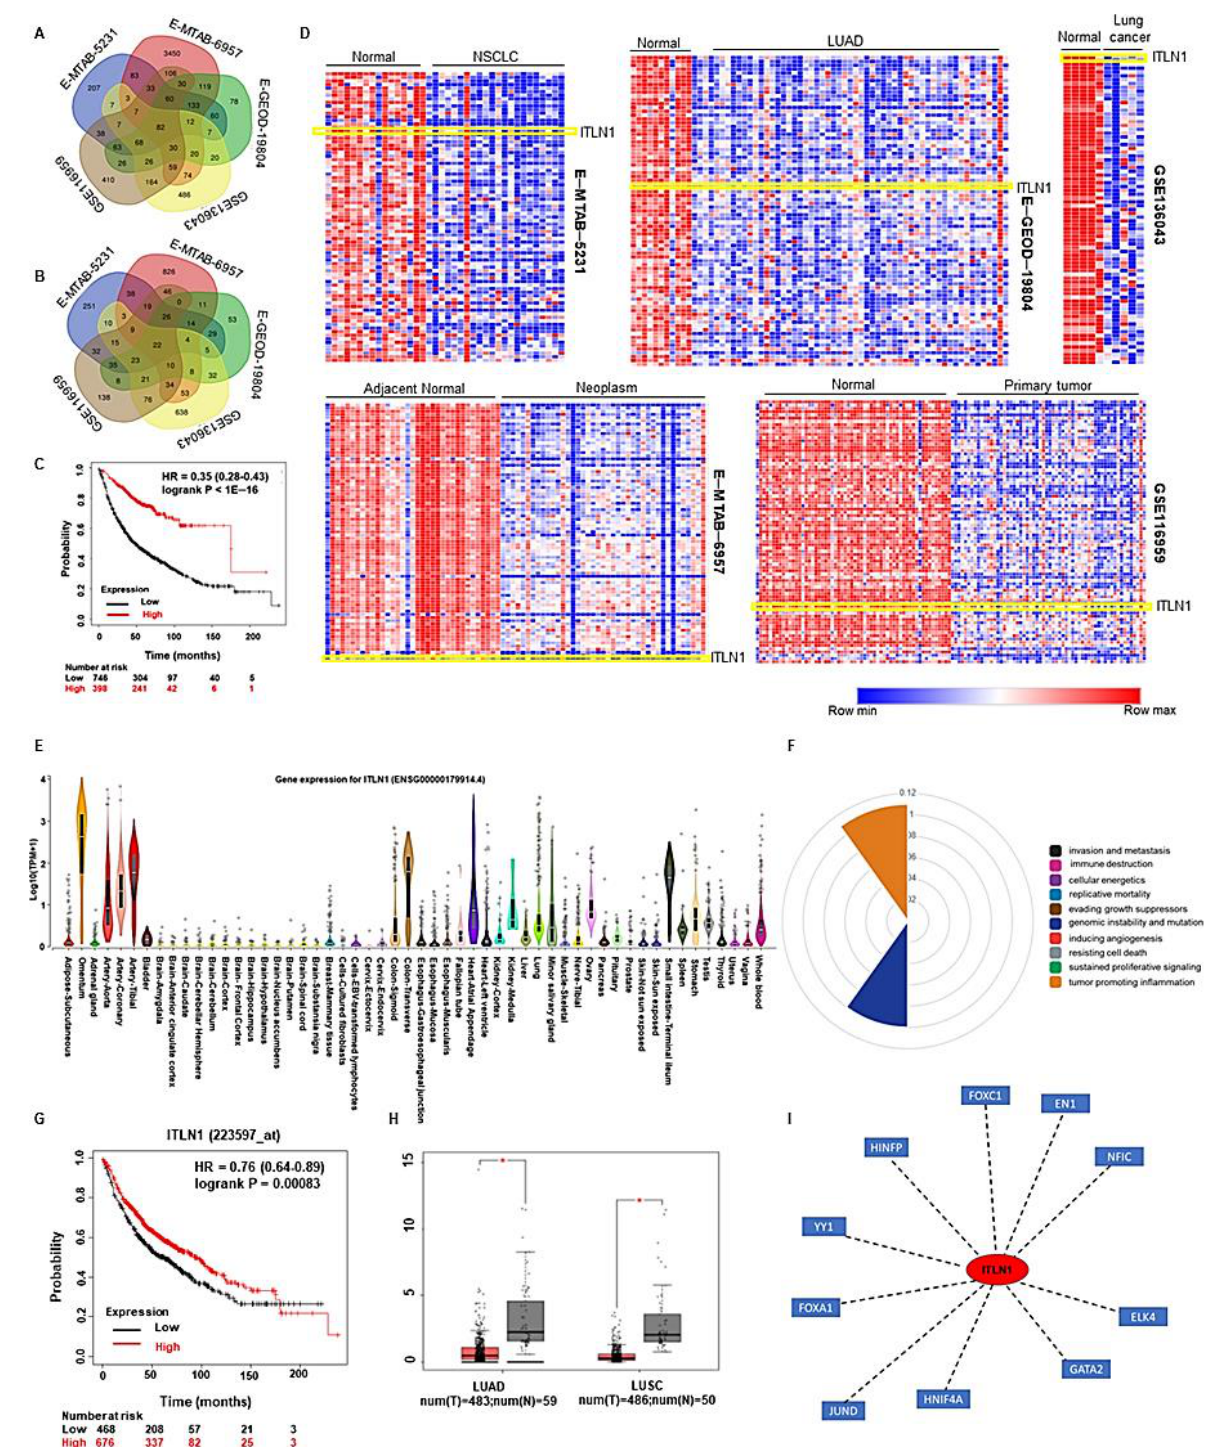
cancer and normal lungs; ( C ) MA plot (M: log ratio, A: Mean average) showing average expression of genes against fold change between lung cancer and normal lungs in respective data sets indicated to the right.